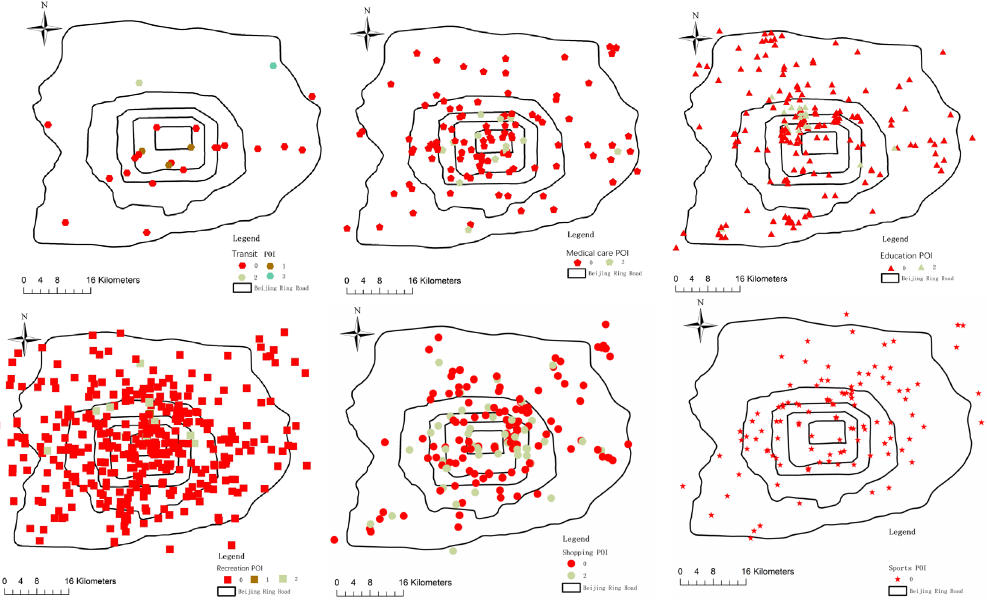
Figure 11. Patterns of changes in pedestrian flow at different hotspot locations in Beijing during the pre-epidemic period.